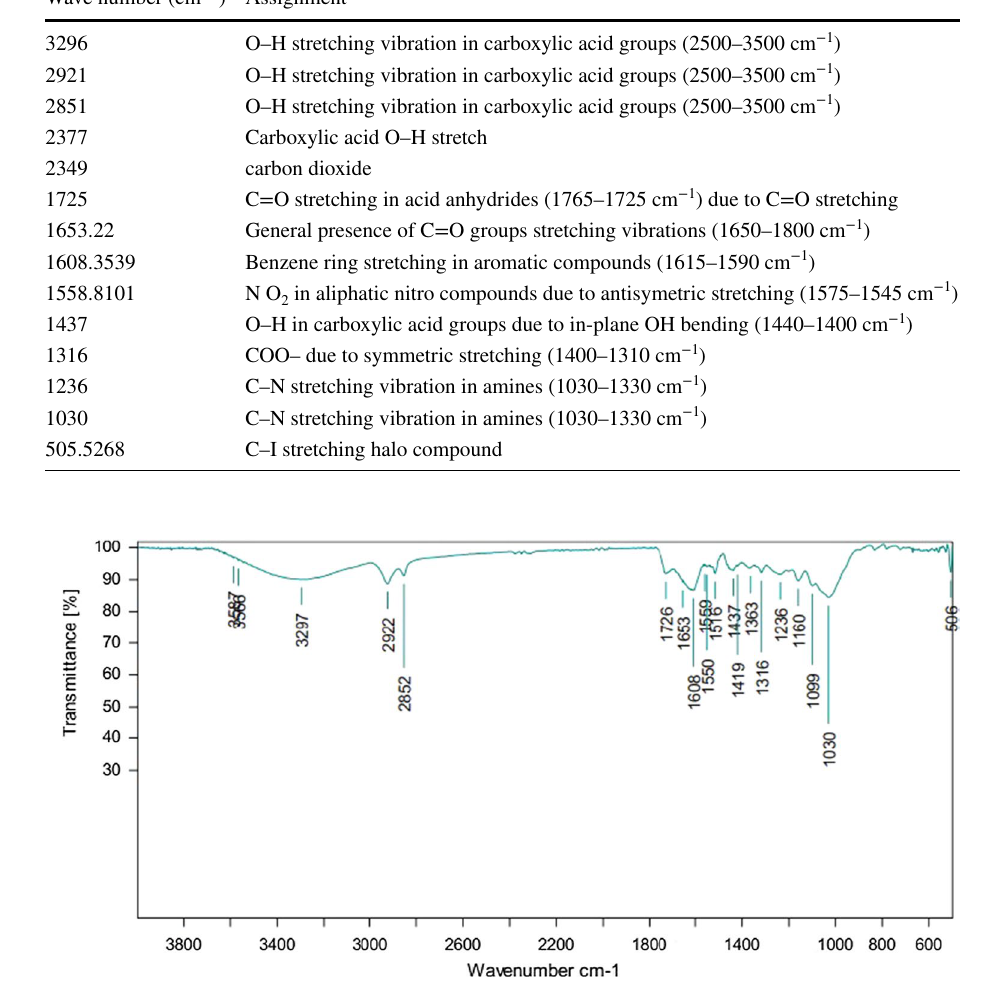
Table 3 FTIR spectrum band assignments